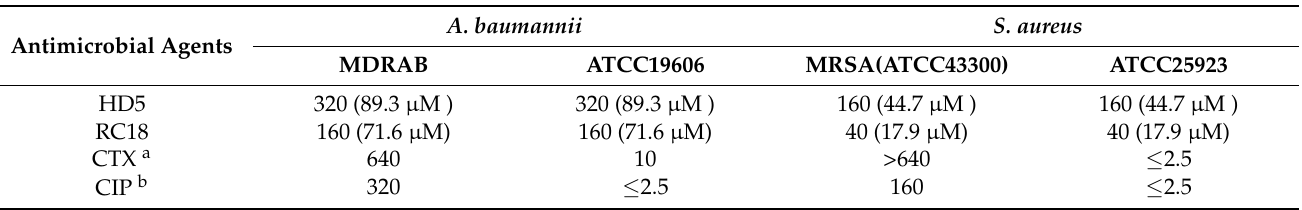
Table 1. MICs ( µ g/mL) of antimicrobial agents required to eliminate A. baumannii and S. aureus , as calculated using the broth microdilution